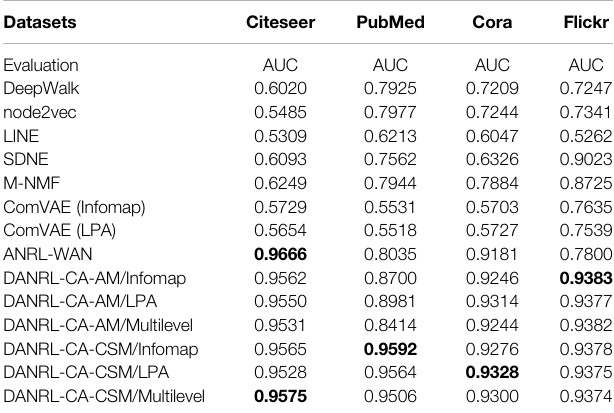
TABLE 10 | Link prediction results on Citeseer, Pubmed, Cora, BlogCatalog and Flickr datasets.